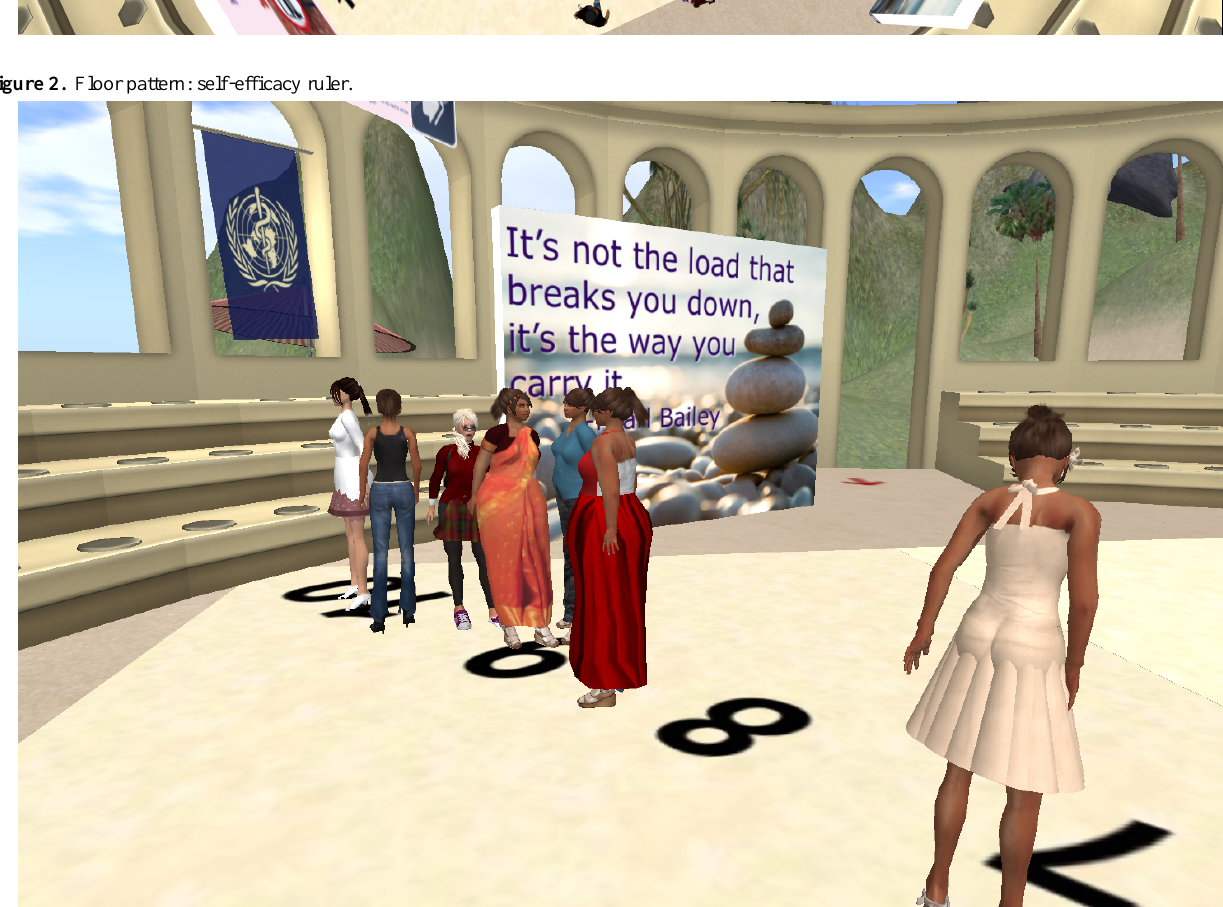
Figure 2. Floor pattern: self-efficacy